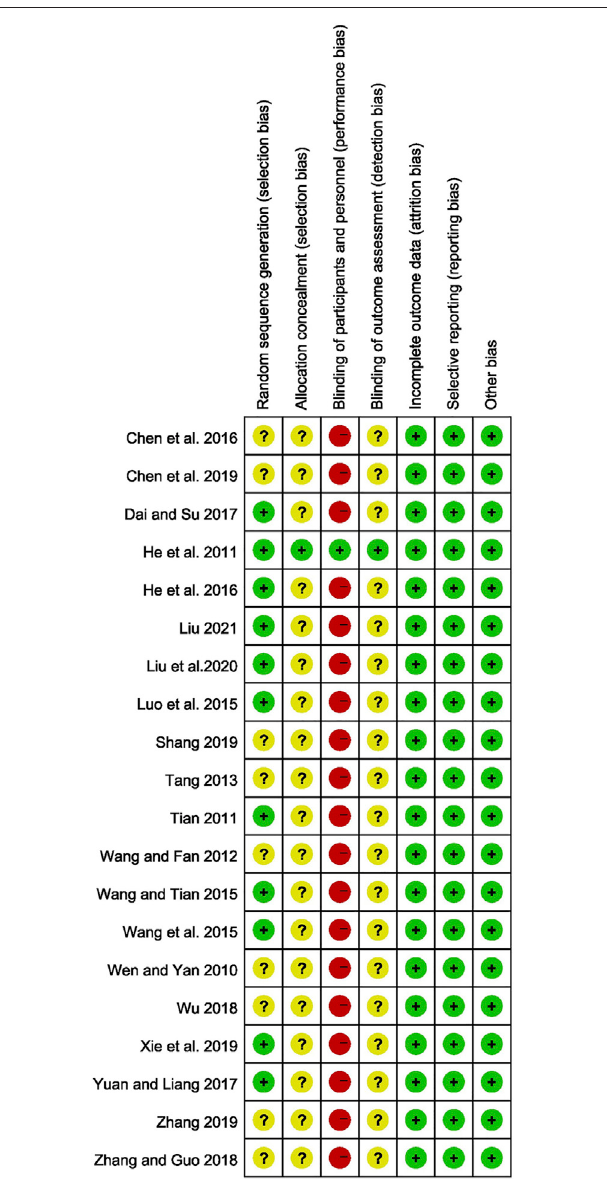
FIGURE 2 | Risk of bias